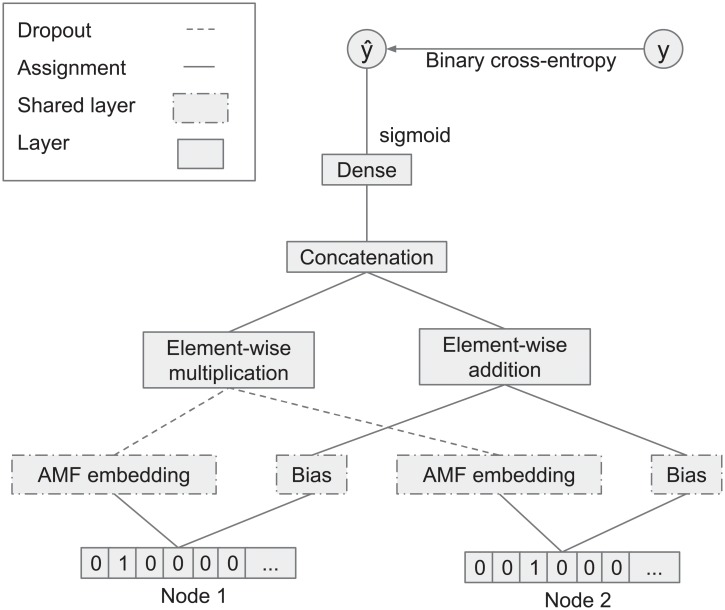
Overview of AMF’s architecture.Drugs are represented as nodes; embedding layers (which act as latent factors) and biases are shared between input nodes. Dropout is used as a regularization mechanism for preventing overfitting.